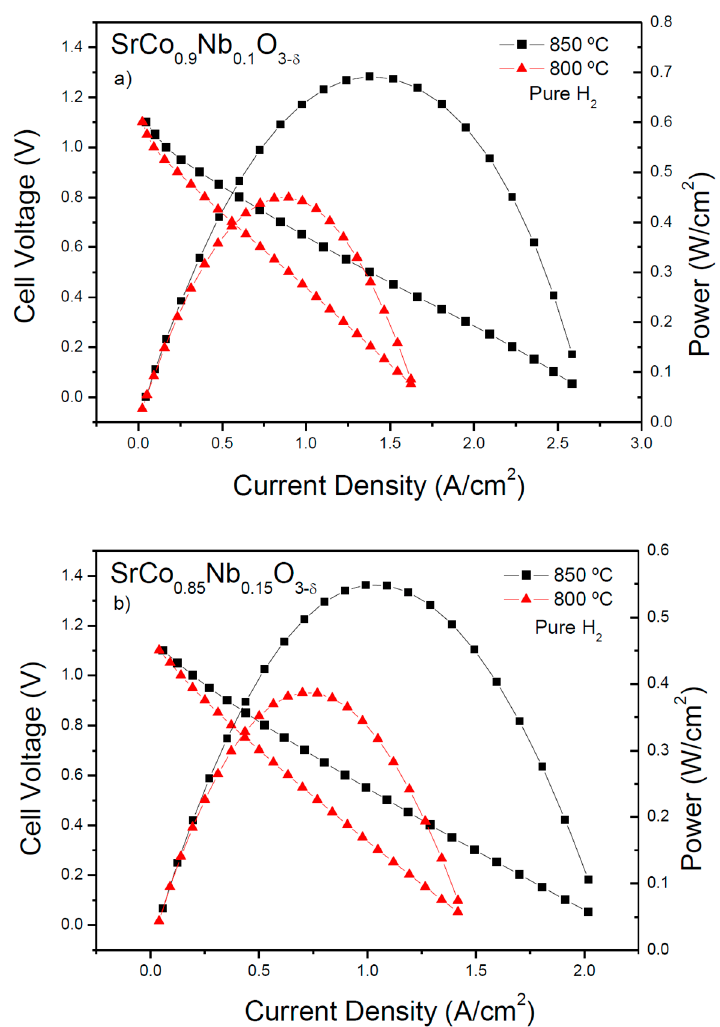
Figure 8. Cell voltage (left axis) and power density (right axis) as a function of the current density for the test cell with ( a ) the configuration SMFO/LDC/LSGM/SrCo 0.9 Nb 0.1 O 3 − δ and ( b ) SMFO/LDC/LSGM/SrCo 0.85 Nb 0.15 O 3 − δ in pure H 2 measured at T = 800 and 850 °C.